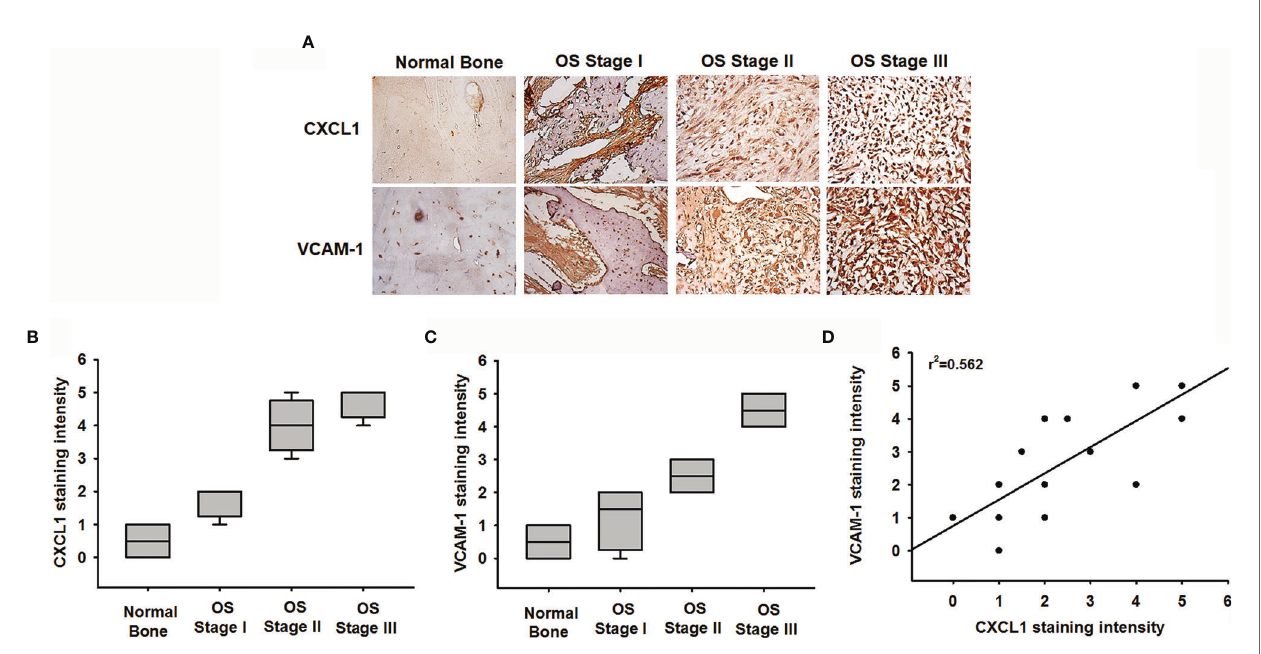
FIGURE 7 | Clinical signi fi cance of CXCL1 and VCAM-1 in osteosarcoma patient specimens. (A) CXCL1 and VCAM-1 expression levels in specimens were determined in a tumor tissue microarray by IHC staining. The stained specimens were photographed using an optical microscope. (B, C) IHC stain intensities were scored from 1 to 5 to quantify CXCL1 and VCAM-1 expression levels in different stages. (D) Correlation between CXCL1 and VCAM-1 expression in human osteosarcoma specimens. Results are shown as